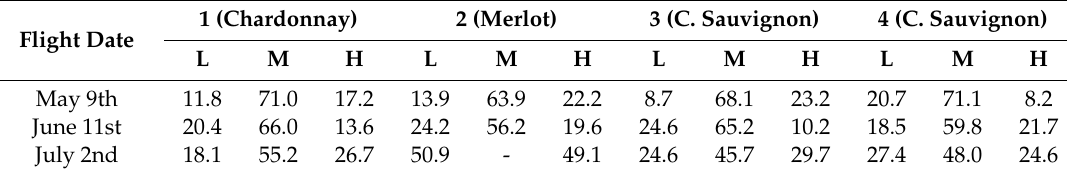
Table 3. Percentage of area in each distinguished vigor map category (low—L, medium—M, high—H) in each